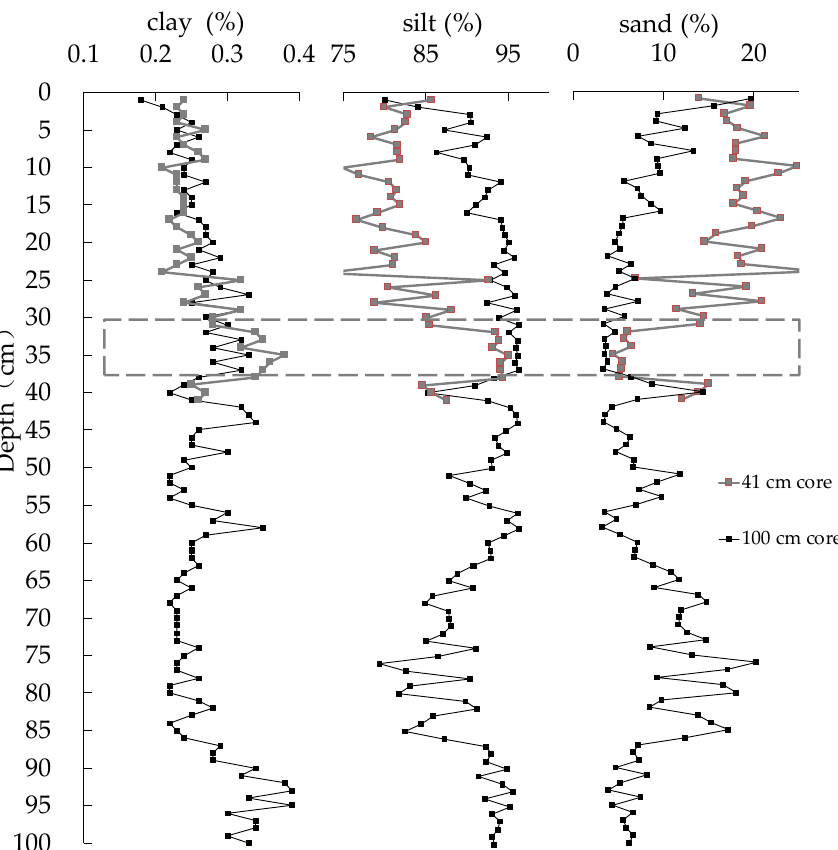
Figure 5. Profiles of the sediment grain components (clay, silt, sand; %) in the 41 core and 100 cm core of Hulun